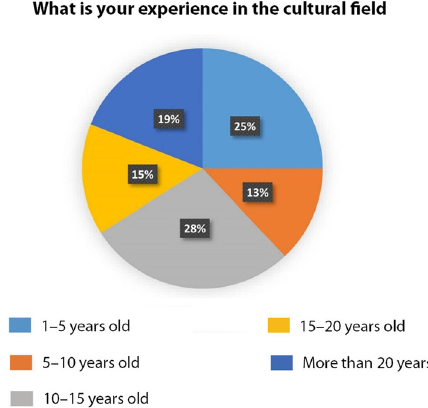
Fig. 7 respondents ’ experience (Source: the authors)